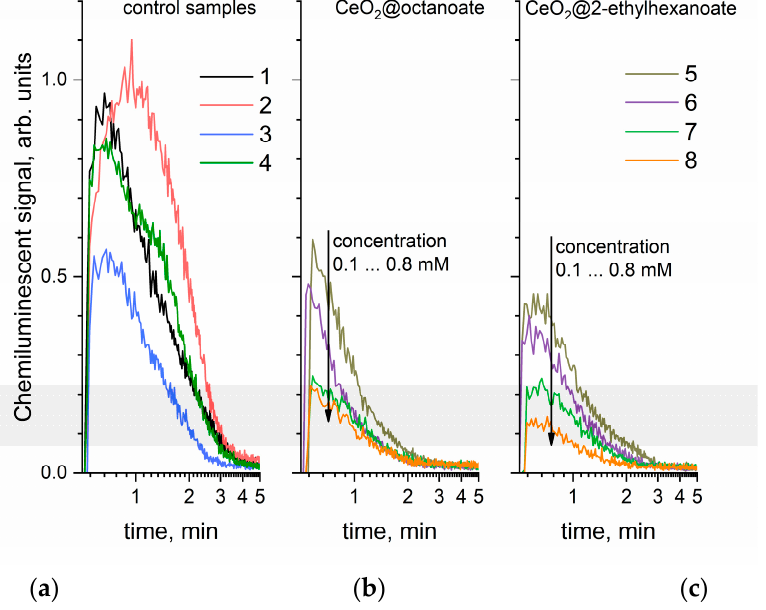
Figure 7. Chemiluminograms obtained by introducing xanthine oxidase into a system containing xanthine, lucigenin, and ( a ) control samples, and CeO 2 sols stabilized with ( b ) octanoic and ( c ) 2-ethylhexanoic acids. The reference samples used: (1) a phosphate buffer solution; (2) a solution of octanoic acid in heptane (4.0 mM); (3) a solution of 2-ethylhexanoic acid in heptane (4.0 mM); (4) heptane. CeO 2 sols in heptane with concentrations (5) 0.1 mM, (6) 0.2 mM, (7) 0.4 mM and (8) 0.8 mM were used for the experiments. In all the panels, the same y-axes ranges are used.